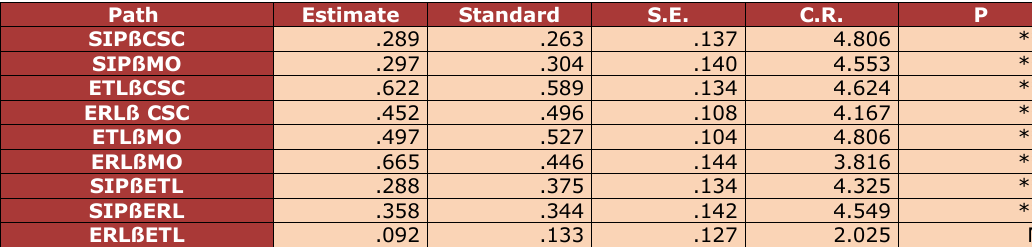
Table 4. Path Efficiencies of